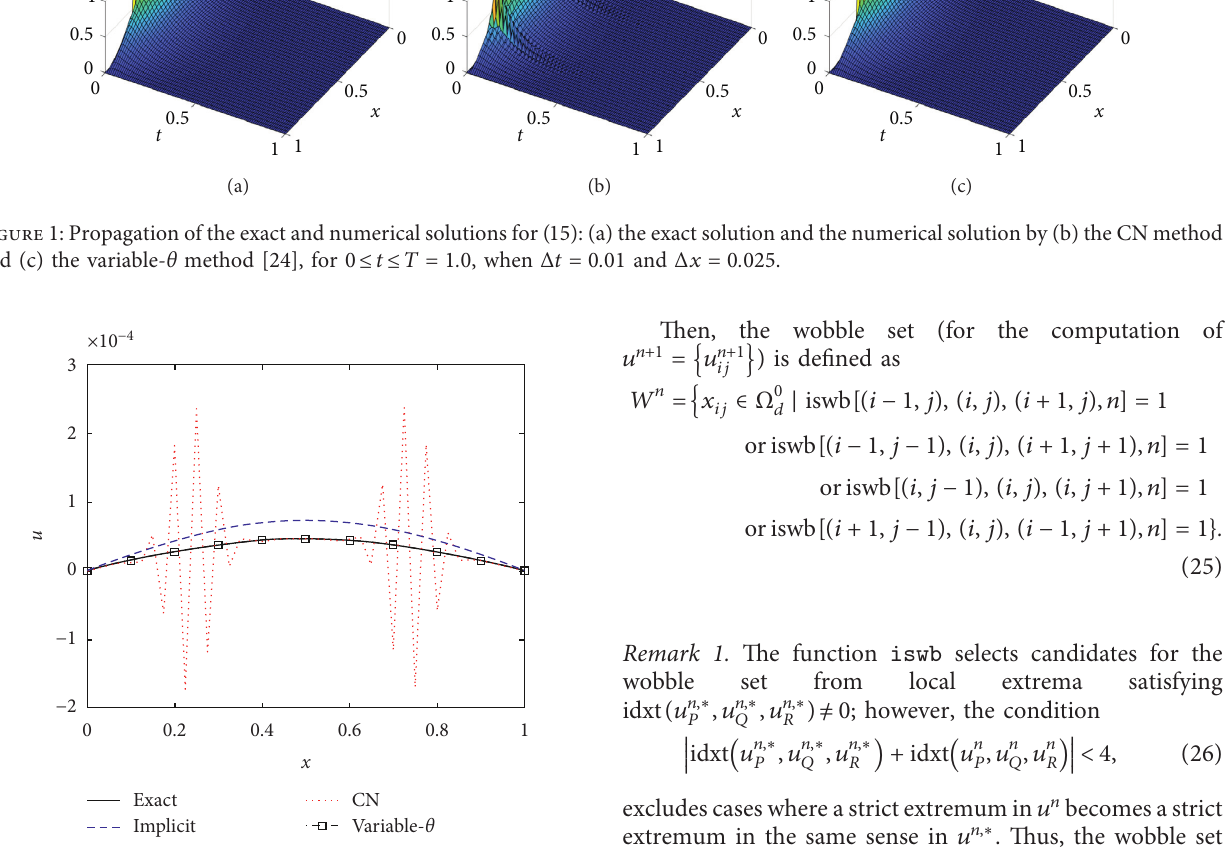
Figure 2: The numerical solutions of (15) at T � 1 . 0, compared with the exact